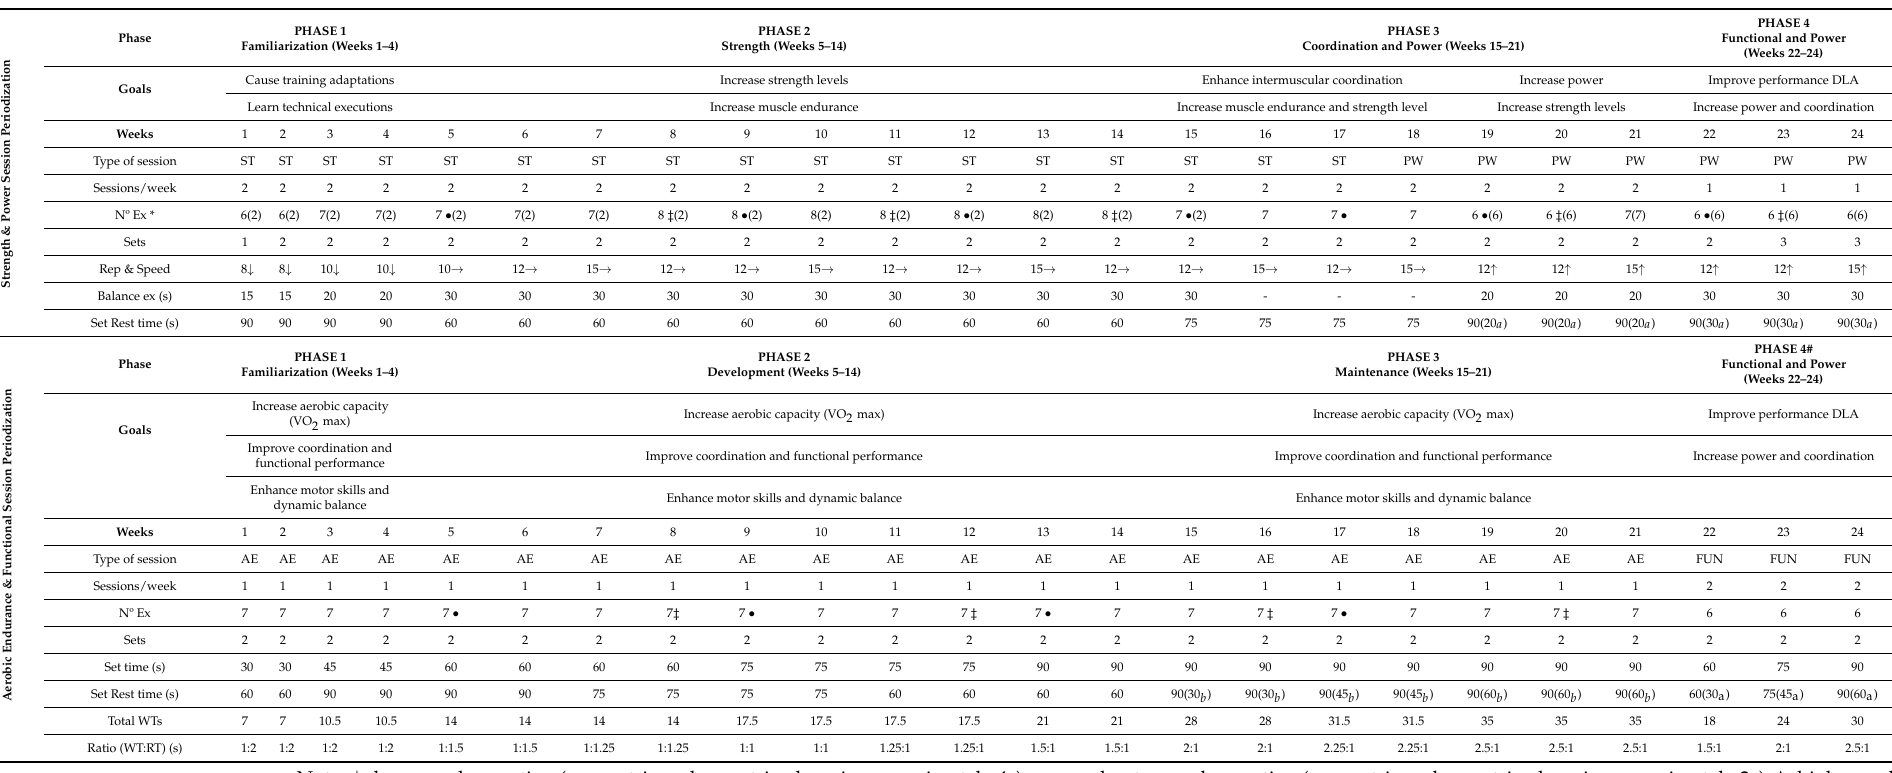
Table 1. Eelder-fit training